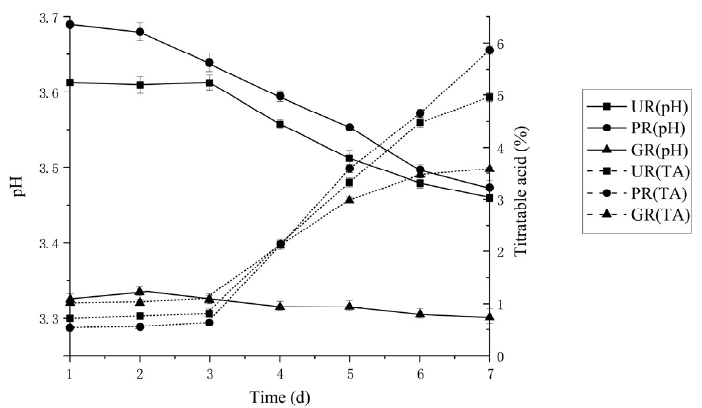
Figure 2. Comparison of pH values and titratable acidities during acetic acid fermentation of Monascus vinegars by three raw materials, respectively. Abbreviations: PR-polished rice, UR-unhusked rice, GR-germinated rice, TA-titratable acidity.